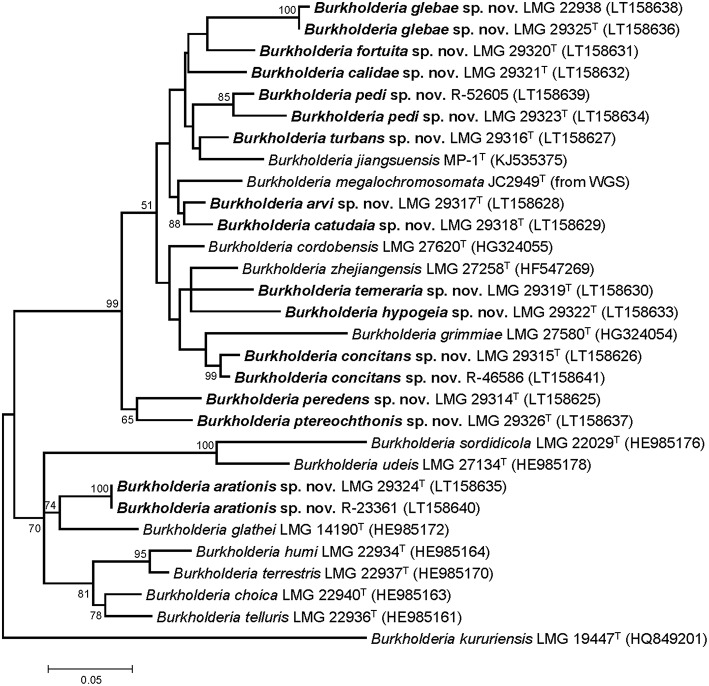
Phylogenetic tree based on partial gyrB sequences of the 17 isolates in this study and type strains of phylogenetically related Burkholderia species. The optimal tree (highest log likelihood) was constructed using the Maximum Likelihood method and General Time Reversible model in MEGA6 (Tamura et al., 2013). A discrete Gamma distribution was used to model evolutionary rate differences among sites [5 categories (+G, parameter = 0.5462)] and allowed for some sites to be evolutionarily invariable ([+I], 37.9331% sites). The percentage of replicate trees in which the associated taxa clustered together in the bootstrap test (1000 replicates) are shown next to the branches if greater than 50%. For B. megalochromosomata JC2949T the gyrB gene sequence was extracted from the genome sequence. The gyrB sequence of B. kururiensis LMG 19447T was used as outgroup. The scale bar indicates the number of substitutions per site.